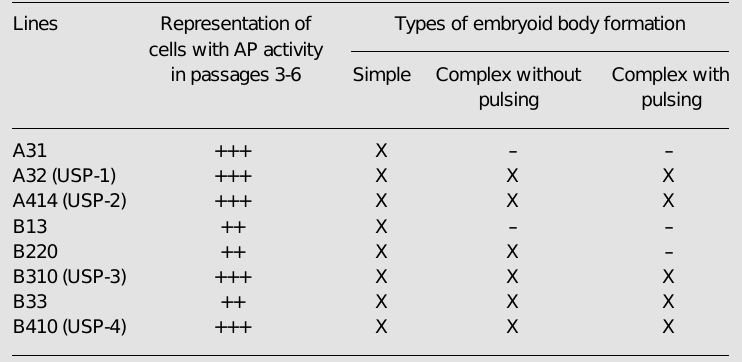
embryonic stem cell lines